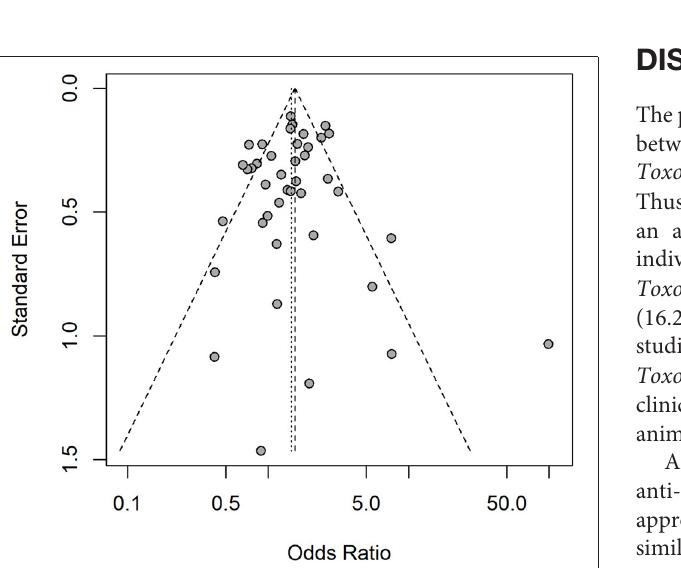
small study size. Thus, it was assumed that the effect size associated with this study does not imply a significant risk of publication